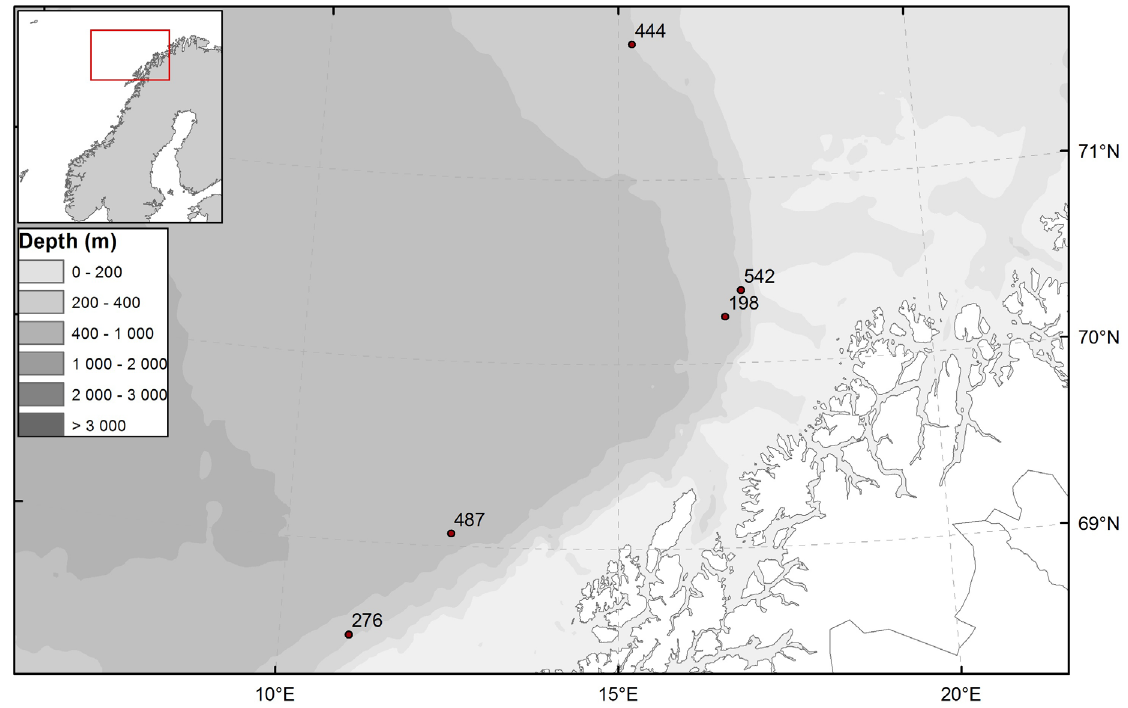
Fig. 1. Part of the MAREANO survey area off northern Norway, with indications of stations where Halirages helgae sp. nov. was